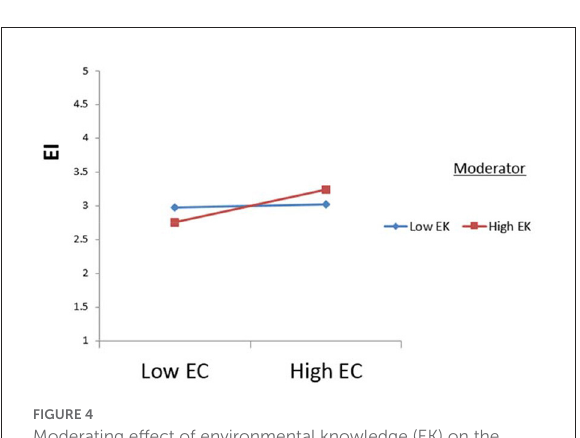
FIGURE4 Moderating effect of environmental knowledge (EK) on the relationship between environmental concern (EC) and ecotourism intention